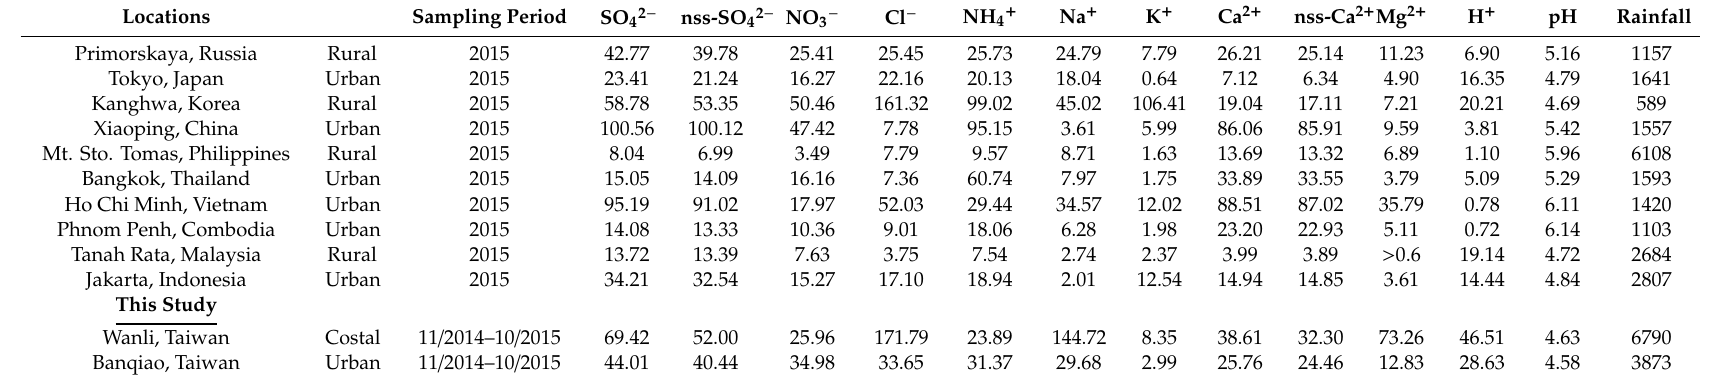
Table 1. The concentrations of major parameters in rainwater at this study and other places in the Asia (units are in µ eq L − 1 except pH and rainfall in mm). Locations